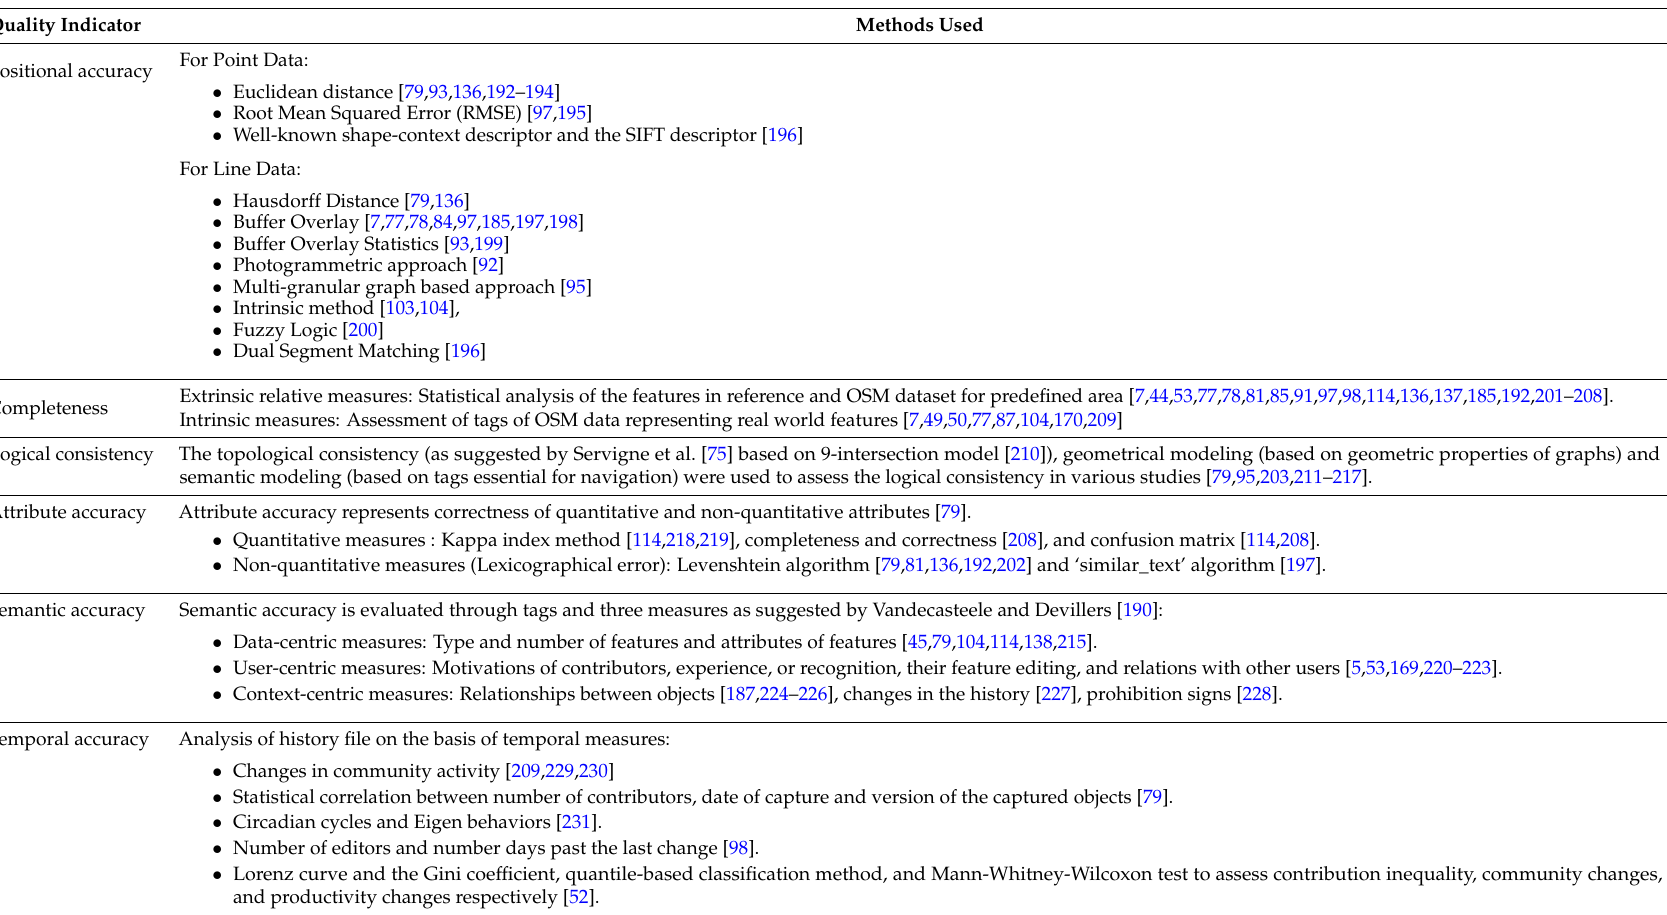
Table 10. Data quality indicators and methods